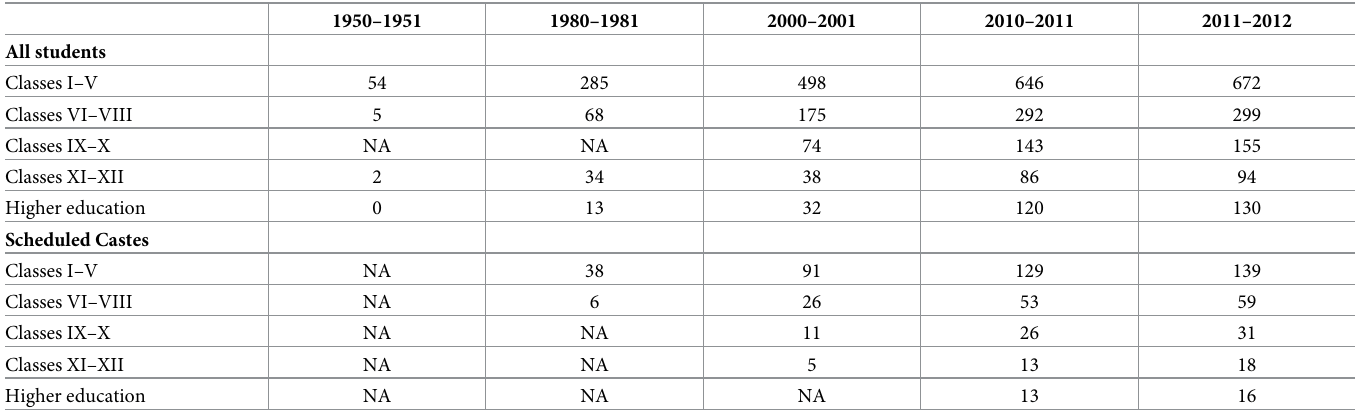
Widespread poverty is also one of the main factors responsible for early marriage in India. According to the Centre for Child Rights statistics, the top five states with the highest GDP ranking have a lower rate of child marriage. Uttar Pradesh and Madhya Pradesh belong to Indian states with higher poverty and a higher than national average proportion of matrimo- nies of girls below the age of 18 years, i.e., 33% and 29%, respectively which means that more than one-fourth of the girls in these states are married before the age of 18 years [29]. Apart from poverty, the practice of "Dowry" also contributes to a higher number of child matrimo- nies [29]. The dowry system in India refers to property that the bride’s family gives the groom, his parents and relatives as a condition of marriage [55, 56]. The gradual reduction of poverty, however, has resulted in a decline in child marriages. In 1973–1974 the poverty ratio declined from 56.4% and 49% in rural and urban areas, respectively to 27.1% and 23.6% in 1999–2000. At the start of the 1970s almost 62% of the population of Madhya Pradesh and 57% of that in Uttar Pradesh lived below the national standard. By the late 20 th and early 21 st centuries, the poverty ratio in these two states was 37% and 31%, respectively [57]. In the rural areas of Madhya Pradesh consumption expenditures increased from 50 INR (Indian Rupee) per person per month in 1973–1974 to 401.50 INR per person per month in 1999–2000, while in the rural areas of Uttar Pradesh, the increase was from 51.3 INR per person per month in 1973–1974 to Table 4. Changes in the numbers of females enrolled in education in